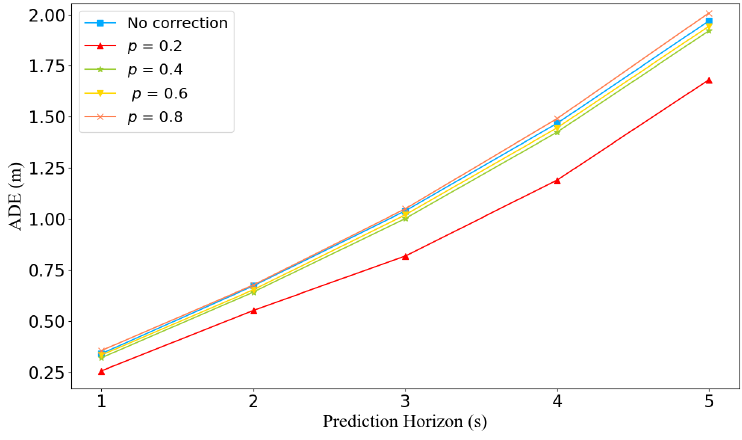
Figure 7. ADE performance under different correction rates p